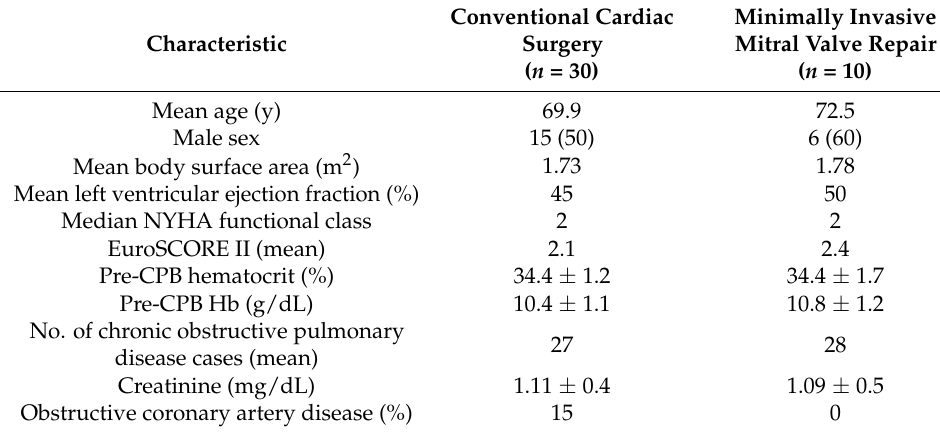
Table 1. Preoperative profile and operative